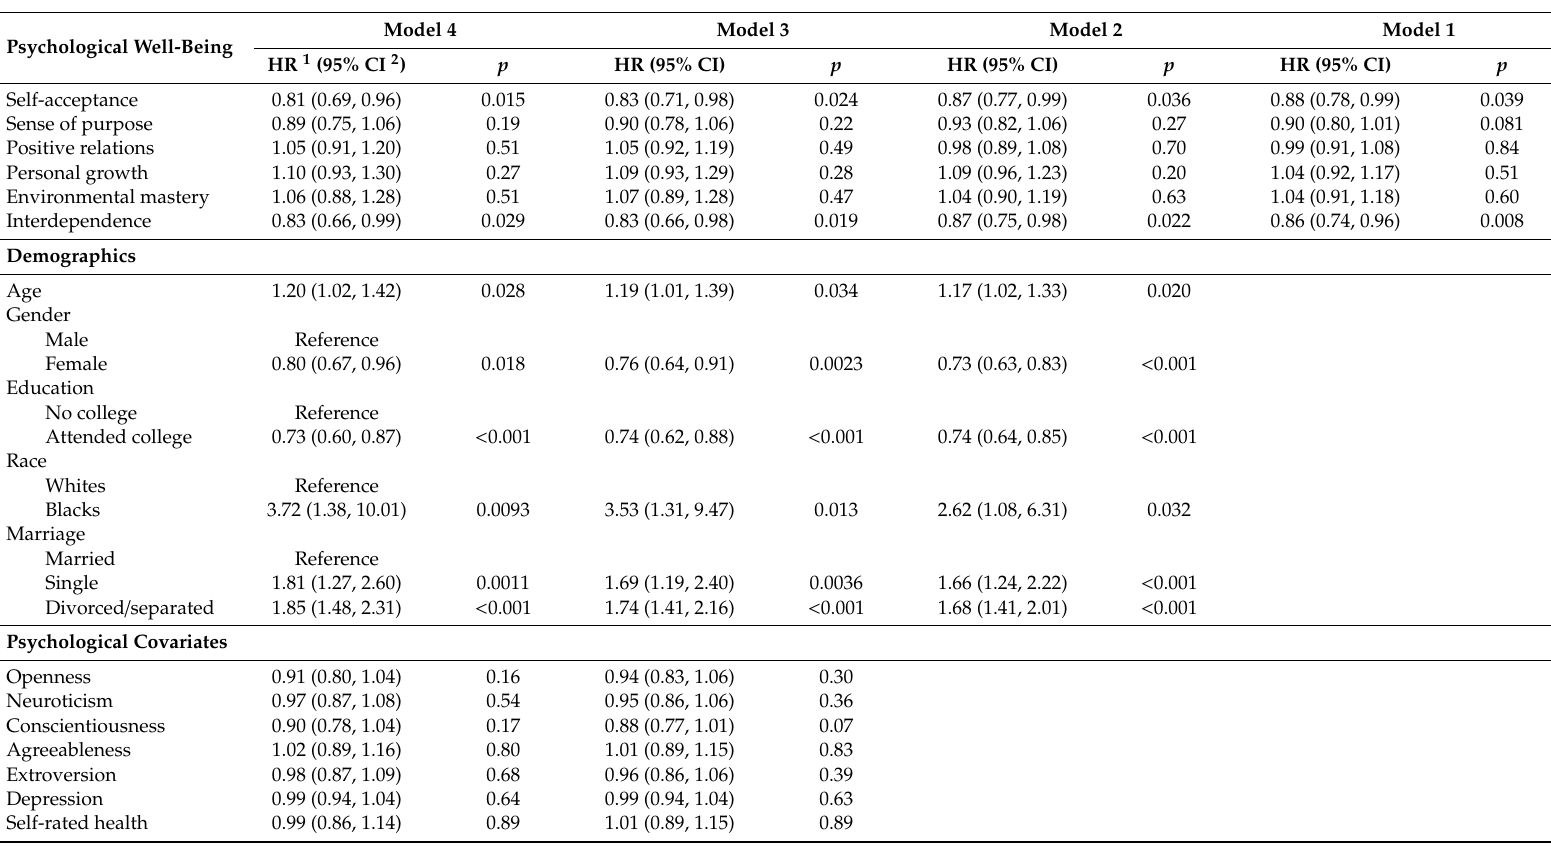
Table 1. Results of multivariable Cox regression model (with time-dependent covariates) for the e ff ect of psychological well-being on all-cause mortality over 20 years. Psychological Well-Being